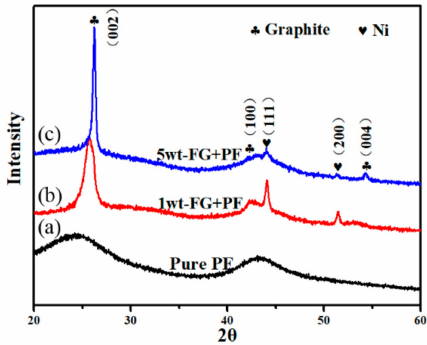
Figure 8. XRD patterns of di ff erent samples pyrolyzed at 1000 ◦ C: ( a ) Pure PF, ( b ) 1 wt.% GNPs / PF with 1 wt.% Ni(NO 3 ) 2 · 6H 2 O, and ( c ) 5 wt.% GNPs / PF with 1 wt.% Ni(NO 3 ) 2 · 6H 2